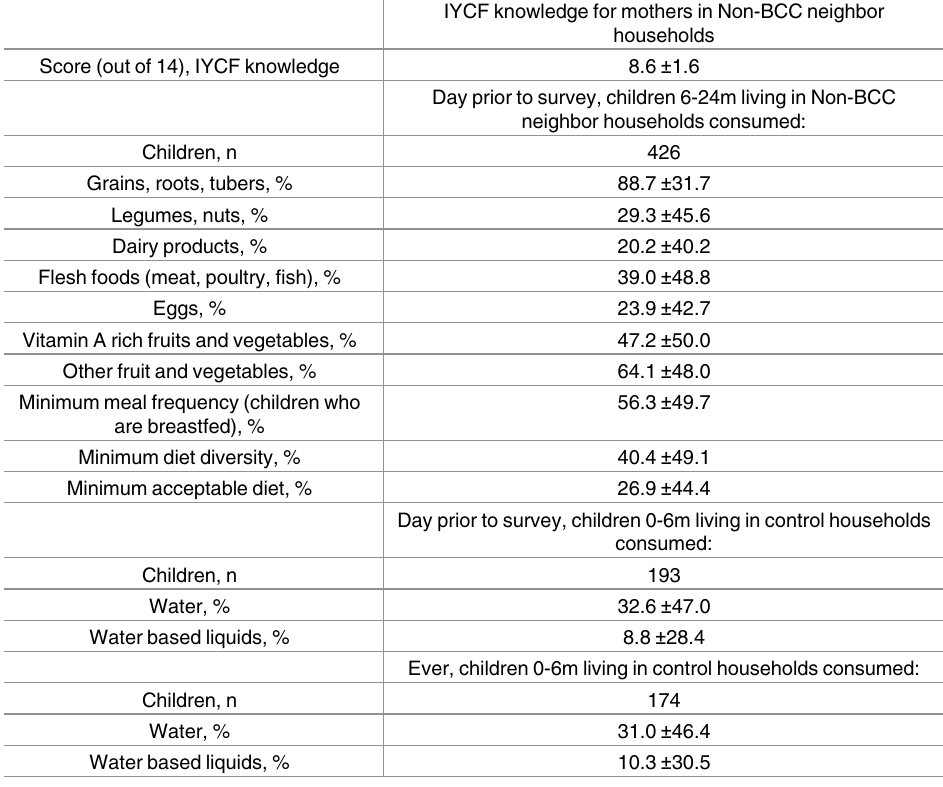
Table 2. Unadjusted mean values of outcome variables for Non-BCC neighbor